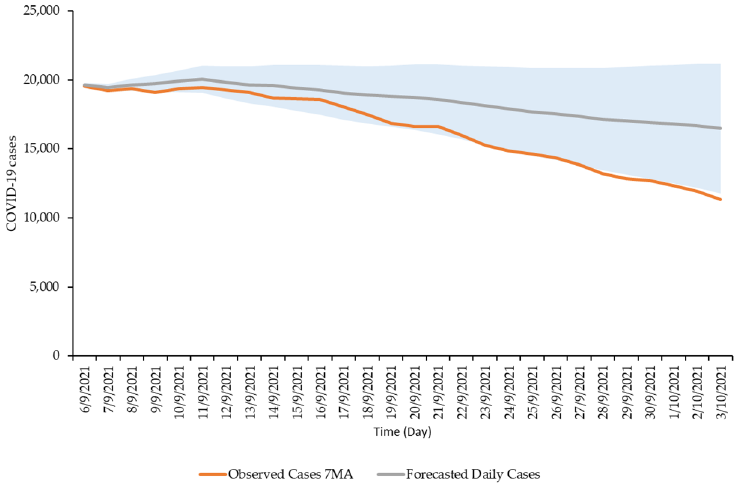
Figure 4. SARIMA (1,2,1) (2,0,0) model forecasted and the 7-day MA observed daily COVID-19 cases from 6 September 2021 to 3 October 2021, Malaysia (28-day forecast).